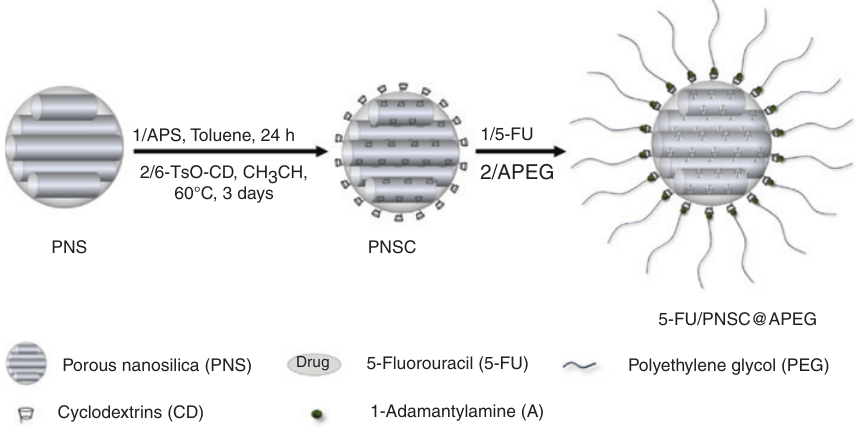
Figure 1: Schematic illustration of the fabrication of self-assembled 5-fluorouracil (5-FU)/adamantylamine-polyethylene glycol-functioned cyclodextrin-porous nanosilica